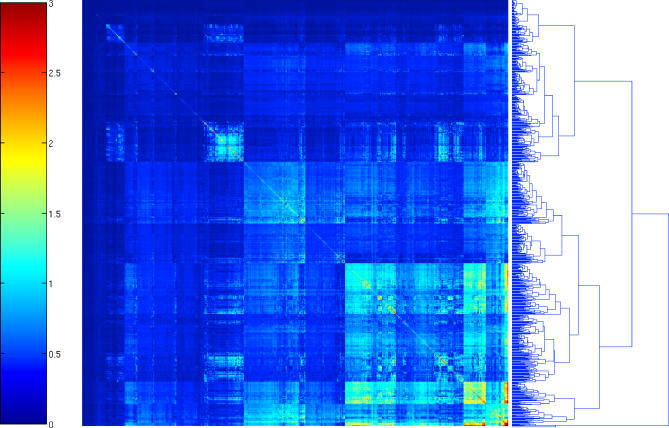
The Entire Matrix of Pair-Wise Coupling Energies of Myosin Motor Domain ResiduesPlotted with blue representing the lowest coupling energy (0 kT*) and red representing the highest coupling energy (3 kT*), respectively. kT* is an arbitrary energy unit. Both horizontal and vertical axes represent the residue number (1–761) of Dictyostelium myosin motor domain (following the clustering analysis).